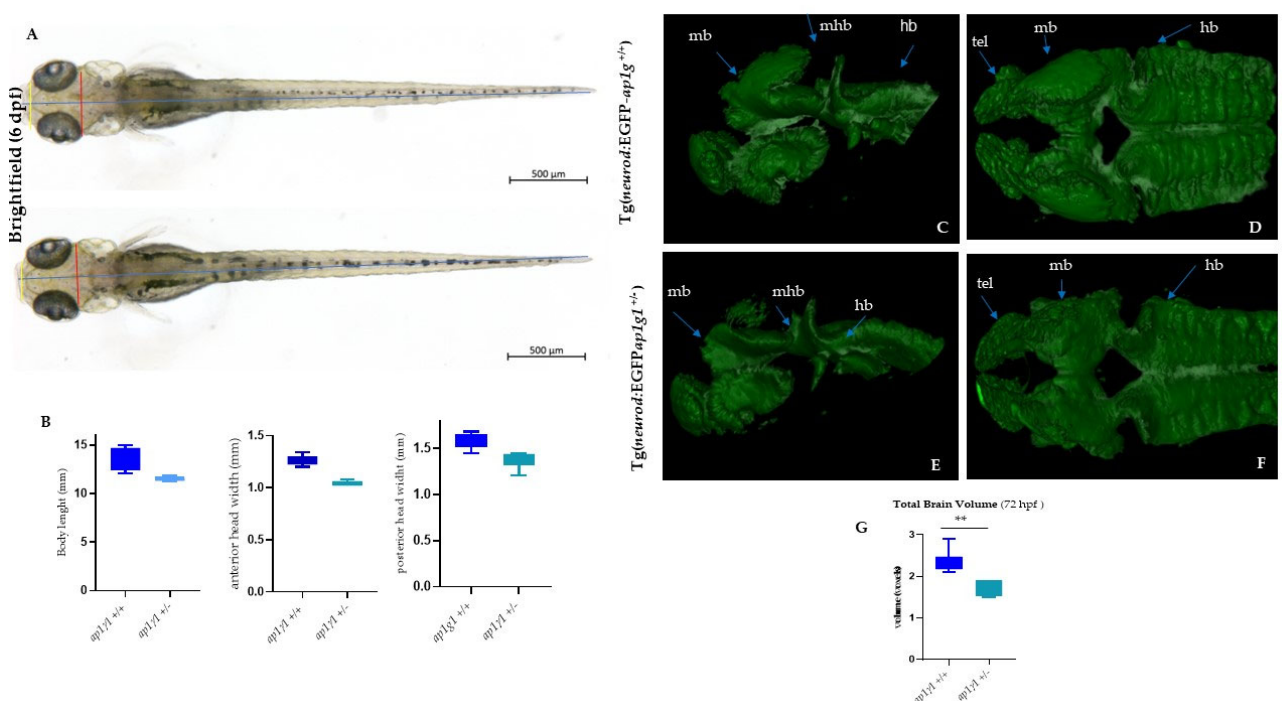
Figure 6. Analysis of body length, head size and 3D LightSheet analysis: ( A ) Bright- fi eld images of ap1g1 +/+ and ap1g1 +/ − larvae at 6 dpf. Lines indicate body length (blue), anterior head width (yellow) and posterior head width (red). Scale bars: 500 mm ( B ) Quanti fi cation of body length, anterior head width and posterior head width measurements of ap1g1 +/+ and ap1g1 +/ − larvae. Data are mean from three independent experiments ( n = 15, 13 and 16 for ap1g1 +/+ and n = 12, 12 and 9 for ap1g1 +/ − . 3D Light Sheet analysis at 72 hpf: Lateral view and ( C , E ) dorsal view ( D , F ) of the anterior part of the central nervous system of wild type and heterozygous embryos. Magni fi cation 25×. ( G ), Quanti fi - cation of total brain volume from. ap1g1 +/+ and ap1g1 +/ − embryos at 72 hpf. Data are mean ± s.e.m. for three independent experiments (n = 15, 15 and 16 for ap1g1 +/+ , and n = 10, 10 and 10 for ap1g1 +/ − embryos, ** p < 0.01 (two-tailed t -test). 1 voxel = 8 µm 3 Abbreviations: mb, midbrain; hb, hindbrain; mhb, midbrain hindbrain boundary; rc, retinal cells; snc, spinal cord neurons.